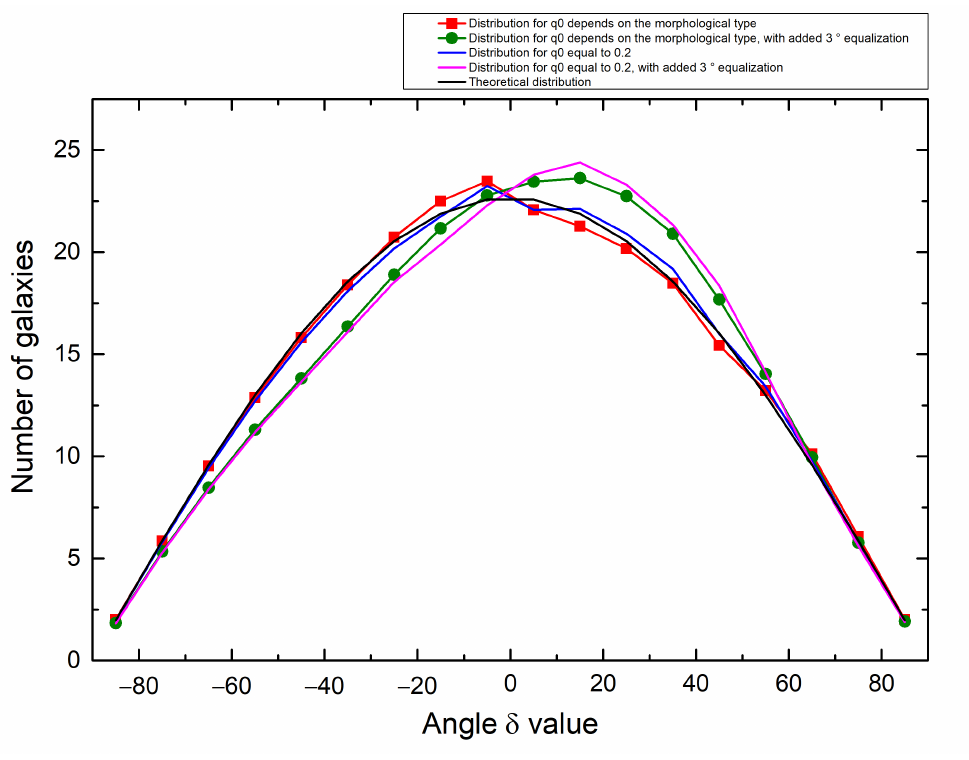
Figure 9. Simulated distributions of the angle δ D for group 53.